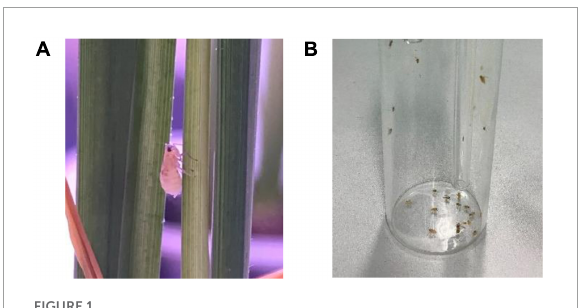
FIGURE1 (A) Individual of Laodelphax striatellus on rice plant, (B) small planthopper